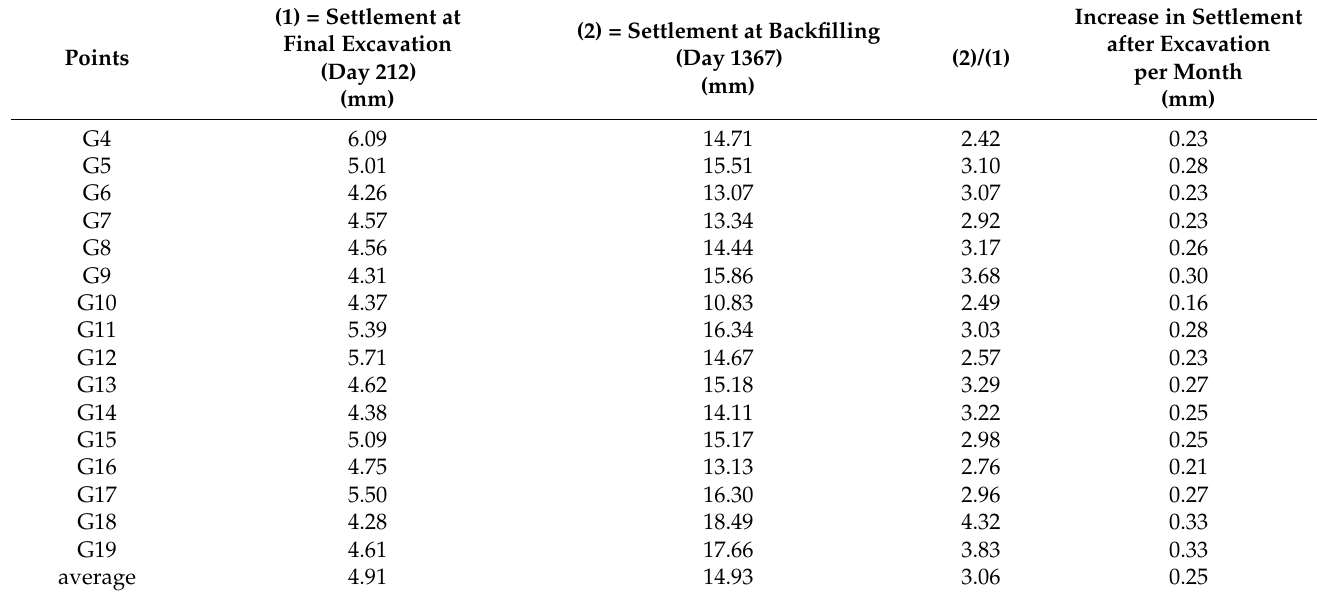
Figure 11. Ground settlement of points 11–19. Table 3. Comparison of ground settlement at final excavation and backfilling.